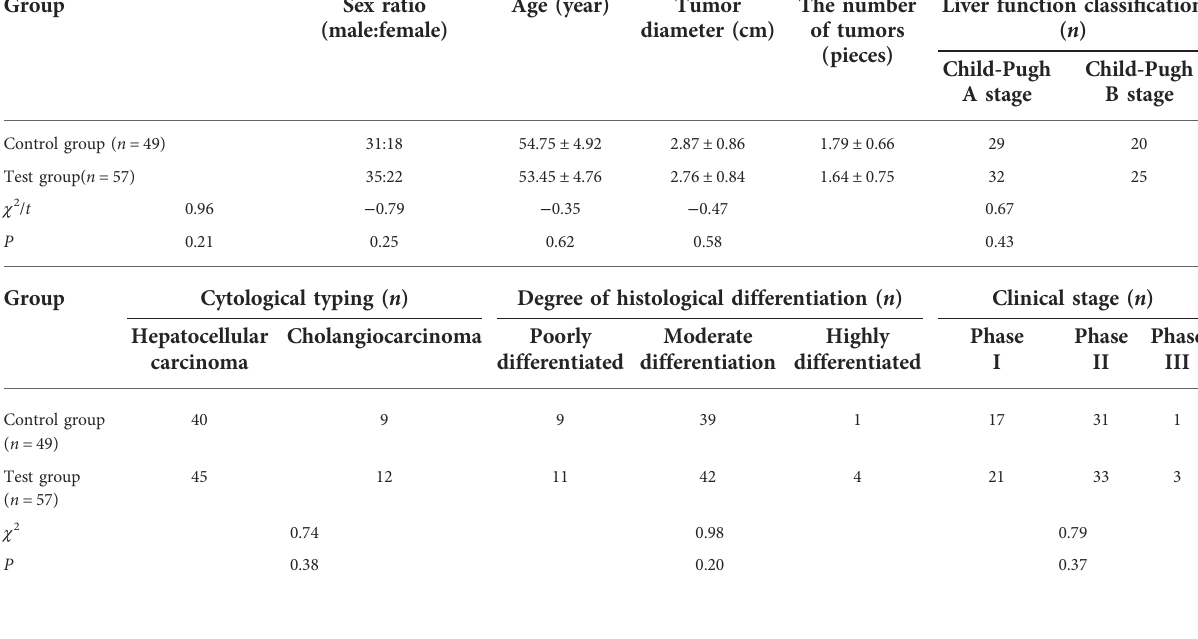
TABLE 1 Comparison of general clinical data of the two groups of patients.